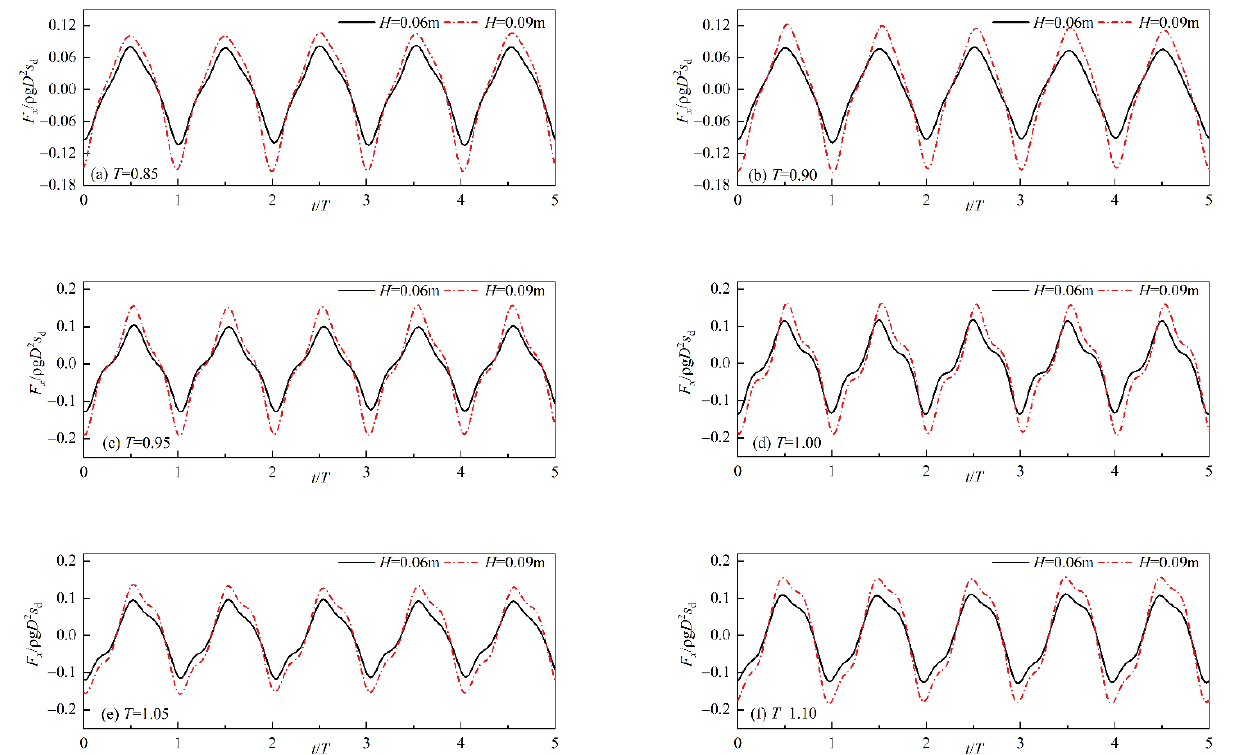
Figure 4. Time histories of longitudinal wave forces for typical cases of ( a ) T = 0.85 s, ( b ) T = 0.90 s, ( c ) T = 0.95 s, ( d ) T =0.10 s, ( e ) T = 1.05 s, and ( f ) T = 1.10 s. ( c ) T = 0.95 s, ( d ) T = 0.10 s, ( e ) T = 1.05 s, and ( f ) T = 1.10